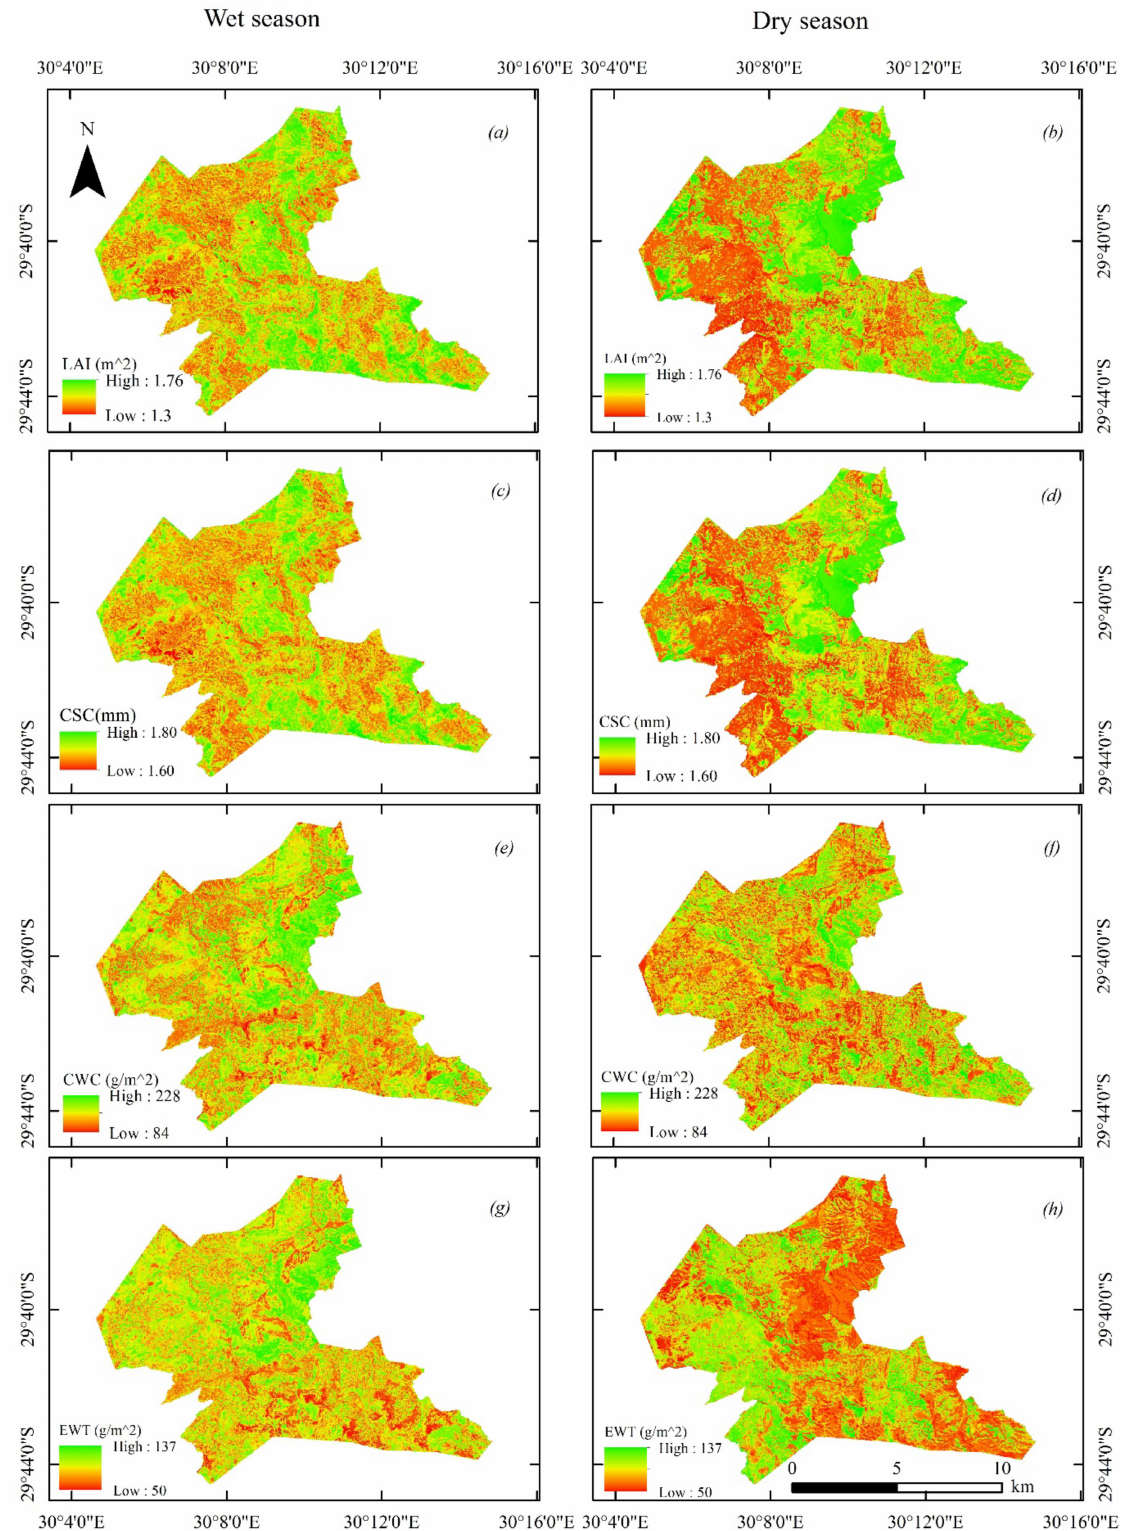
Figure 5. Spatial distribution of modelled LAI ( a , b ), CSC ( c , d ), CWC ( e , f ), and EWT ( g , h ) for the wet and dry seasons,